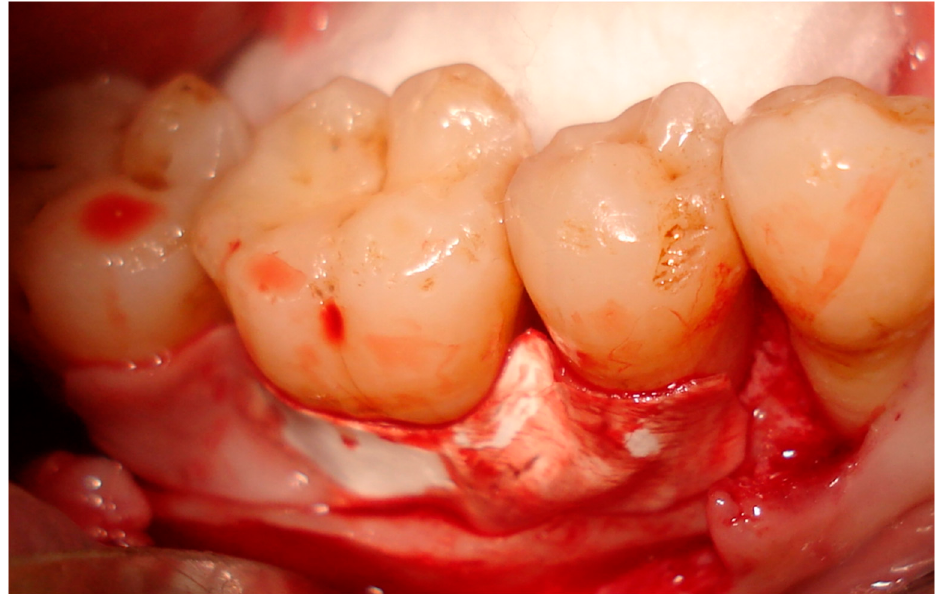
Figure 2. Third-generation pericardium membrane adaptation over a furcation defect. Postoperative instructions were given for the use of 0.1% chlorhexidine mouthwash twice daily for two weeks, for completing the course of the antibiotic medication combina- tion in one week, and for using anti-inflammatory and analgesic medications if necessary. These instructions were given to all participants. Periodontal dressing and suture removal were performed after 14 days. Supportive periodontal therapy was then performed monthly until the end of the study